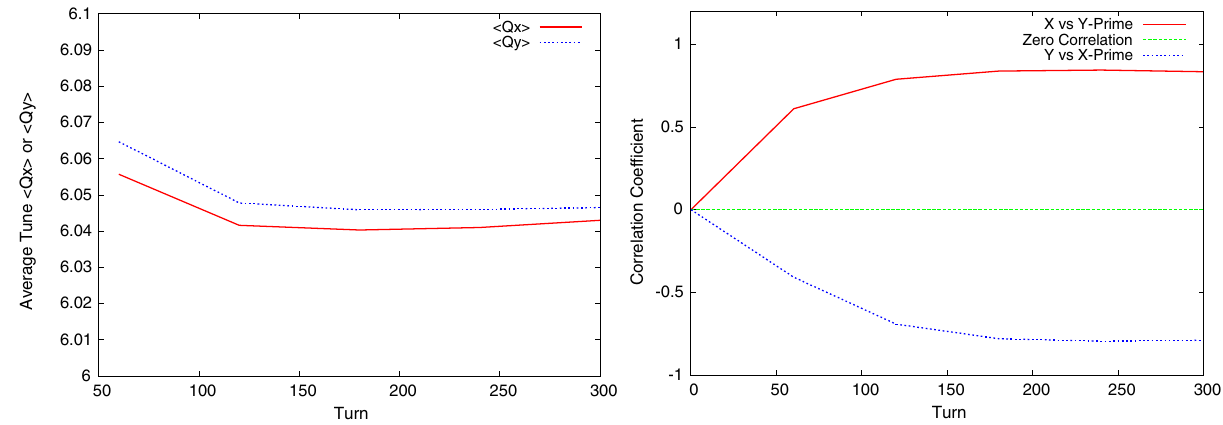
FIG. 12. (Left) Average horizontal and vertical incoherent tunes as functions of the turn number. (Right) Normalized correlation coefficients for x versus y 0 and y versus x 0 as functions of the turn number. The correlation coefficients are displayed for the beam at the